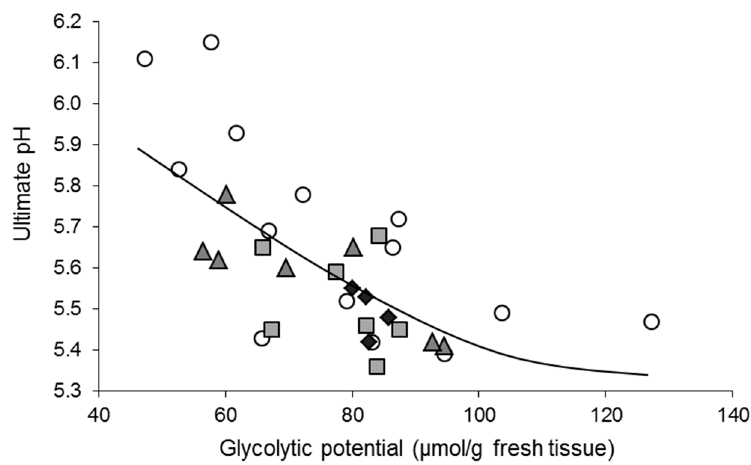
Figure 10. Pig Semimembranosus (SM) slaughtered following gas stunning: relationship between the glycolytic potential 45 min postmortem (GP) and pH measured 24 h postmortem. The best logarithmic fit was ultimate pH = 8.40 − 65 × ln (GP), illustrated by the curved line ( r = 0.69; p < 0.0001). The different symbols refer to pigs with different liver GP; circles: 10–39, squares: 40–99, triangles 100–170; rhombuses: 268–289 µmol/g fresh tissue; none of the pigs had values between 170 and 268 µmol/g. GP in muscle and liver was calculated from lactate, glucose and glycogen content, following [138] . The results illustrate that with GP below 80 µmol/g fresh tissue, ultimate pH rises. They also show that some of the pigs with low muscle glycogen had liver GP contents over 100 µmol/g. Hence, although liver glycogenolysis helps to replenish glucose, the remaining liver glycogen contents did not match SM muscle contents. This may be due to a combination of factors; for instance, resting liver glycogen contents may have varied, the rate of glycogenolysis may depend on additional factors, such as stress, or there may be a delay between need and actual glycogenolysis. The figure illustrates the heterogeneity of physiological adaptive responses. Adapted from [139], with permission from ADIV,